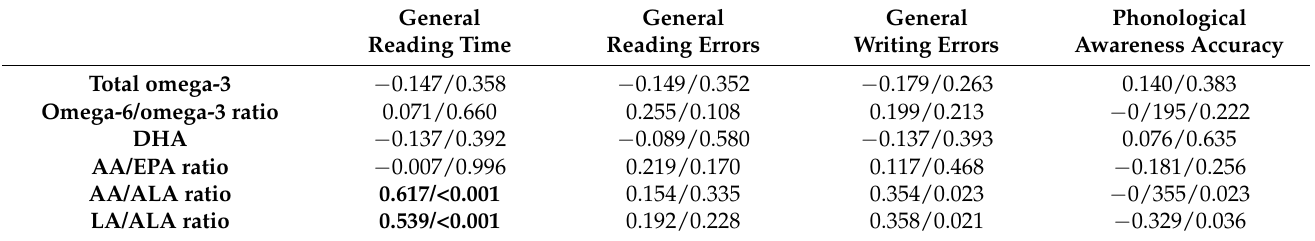
Table 3. Partial correlations (controlling for age) between PUFA levels and reading/writing/phonological processing measures ( n = 42, alpha = 0.017). Reported values are Pearson’s correlation index r/ p -value. In bold, significant correlations.